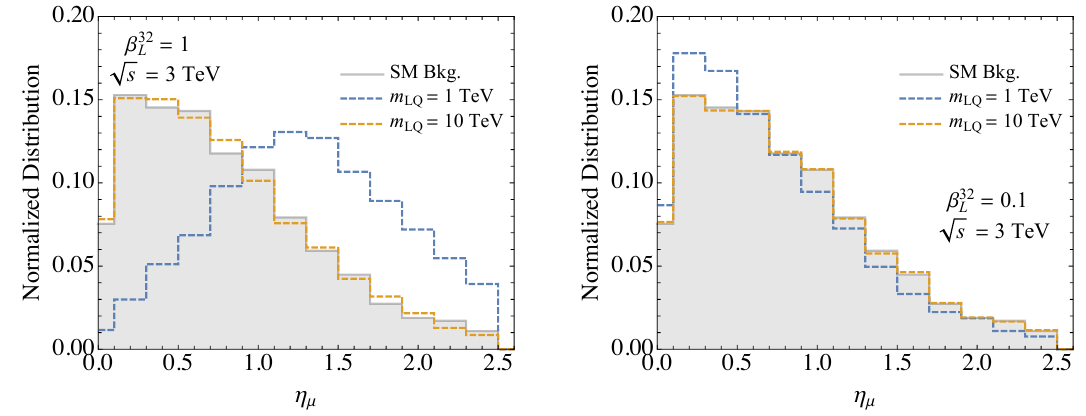
Figure 11 . Distribution of DY events in η for two different values of LQ mass and its coupling to √ µ L and b L ( β 32 ). We use s = 3 TeV for generating these results. We observe that SM distribution L (gray) can be significantly different from the LQ model prediction, which is a consequence of different SM and LQ diagram topologies. We use these different distributions to search for the LQ signal in this